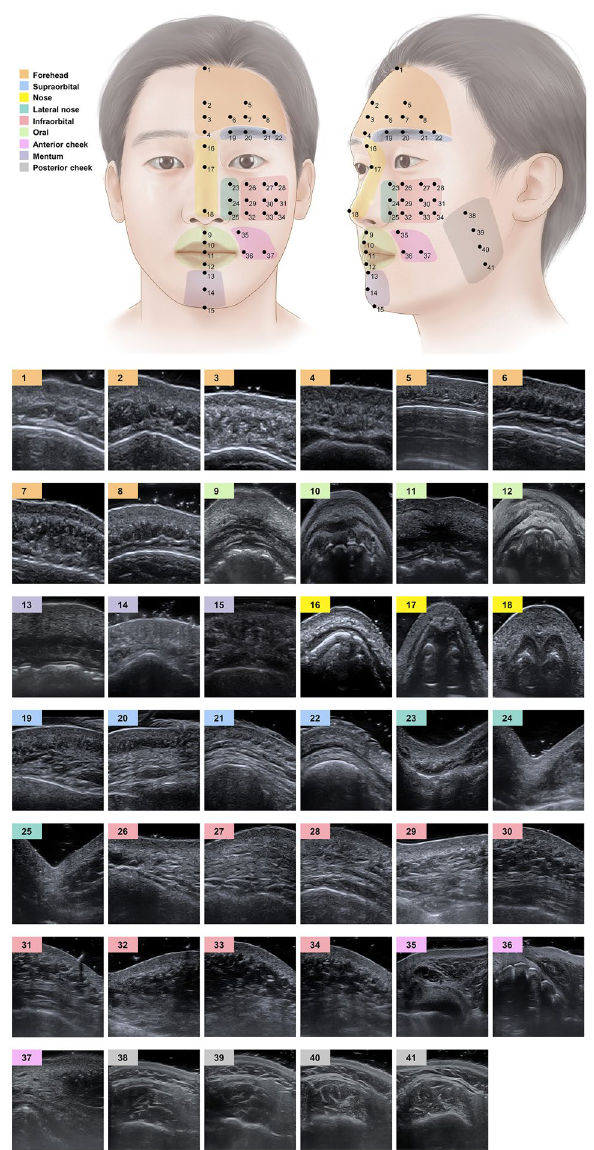
Figure 1. Nine facial regions, their landmarks, and US images corresponding to each landmark. Transverse US images at the region were used for deep learning models. Forehead : 1 , trichion (hair line at the midline); 2 , metopion (midpoint of bilateral frontal eminence), 3 , half point between 2 and 4; 4 , glabella; 5 , frontal eminence; 6 , meeting point between lines passing 3 and medial canthus; 7 , meeting point between lines passing 3 and mid-pupil; 8 , meeting point between lines passing through 3 and lateral canthus. Oral : 9 , half point between subnasale and 10; 10 , lower point on cupid’s bow; 11 , stomion; 12 , midpoint of lower vermillion border. Mentum: 13 , deepest point of the chin at the midline; 14 , pogonion; 15 , gnathion. Nose: 16 , sellion; 17 , rhinion; 18 , pronasale. Supraorbital : 19 , meeting point between lines passing 20 and the medial canthus; 20 , superior orbital rim at the mid-pupillary line; 21, meeting point between lines passing 20 and the lateral canthus; 22 , meeting point between lines passing 20 and the lateral orbital rim. Lateral nose : 23 , meeting point between lines passing 26 and the medial canthus; 24 , point between 23 and 25; 25 , alare. Infraorbital : 26 , superior orbital rim at the mid-pupillary line; 27 , meeting point between lines passing 26 and the lateral canthus; 28 , meeting point between lines passing 26 and the lateral orbital rim; 29 , point between 26 and 32; 30 , point between 27 and 33; 31 , point between 28 and 34; 32 , meeting point between lines passing alare and middle pupil; 33 , meeting point between lines passing alare and the lateral canthus; 34 , meeting point between lines passing alare and the lateral orbital rim. Anterior cheek : 35 , meeting point between the line passing 9 and nasolabial folds; 36 , meeting point between lines passing stomion and middle pupil; 37 , meeting point between lines passing stomion and lateral cantus. Posterior cheek : 38–41 , points that divide the masseter by the upper and lower